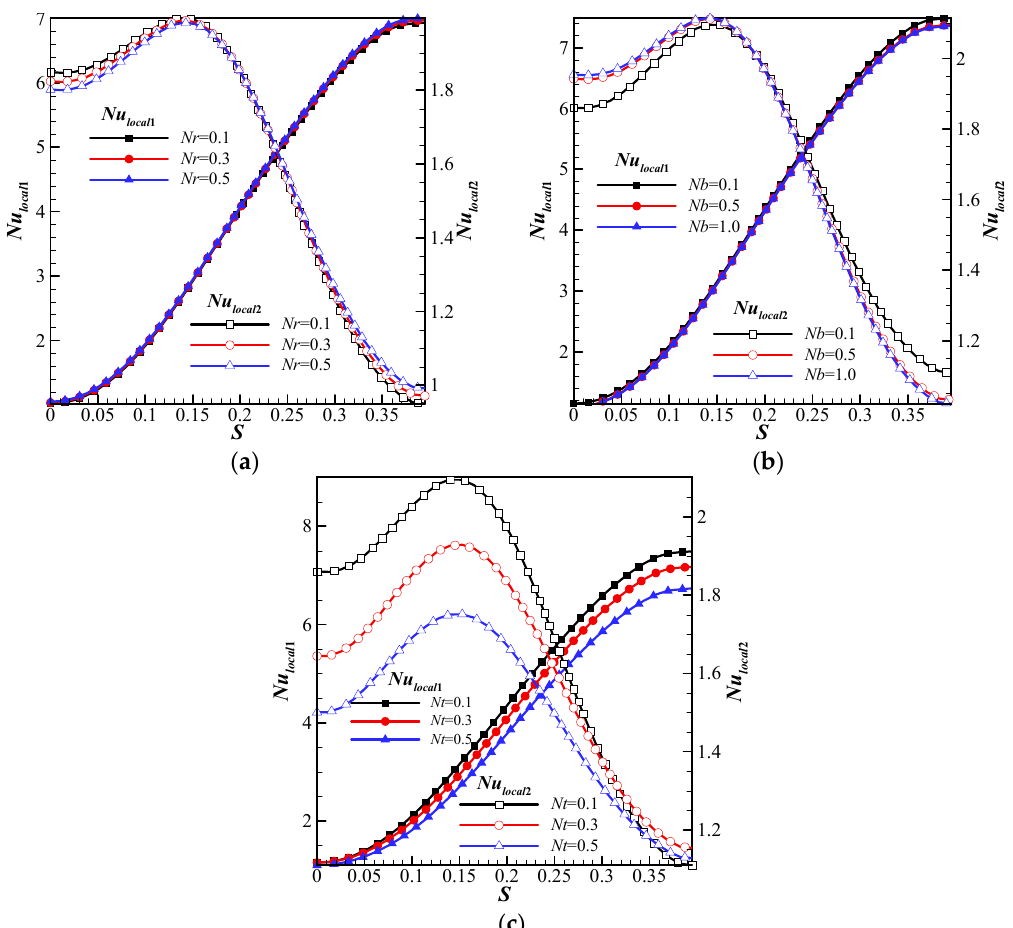
Figure 11. Profiles of local Nusselt number for variation of ( a ) 𝑁𝑟 , ( b ) 𝑁𝑏 , and ( c ) 𝑁𝑡 along two semi-cylinders for 𝛾 (cid:3045) = 1.0 , 𝑀𝑛 (cid:3033) = 1000 , Ra = 10 5 , 𝐻𝑎 = 20 , and 𝐿𝑒 = 10 .